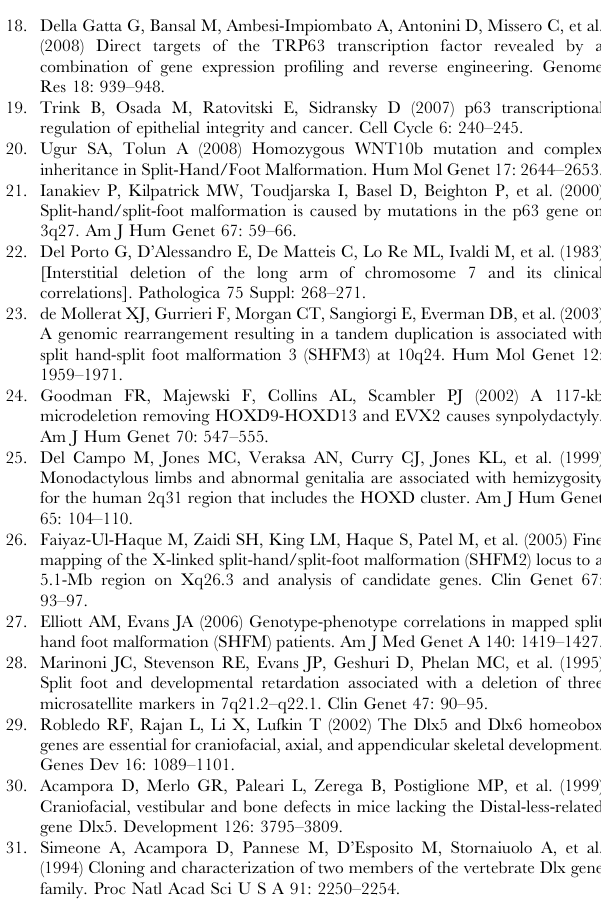
Table S7 Genes potentially involved in SHFM mouse models or human SHFM phenotypes.